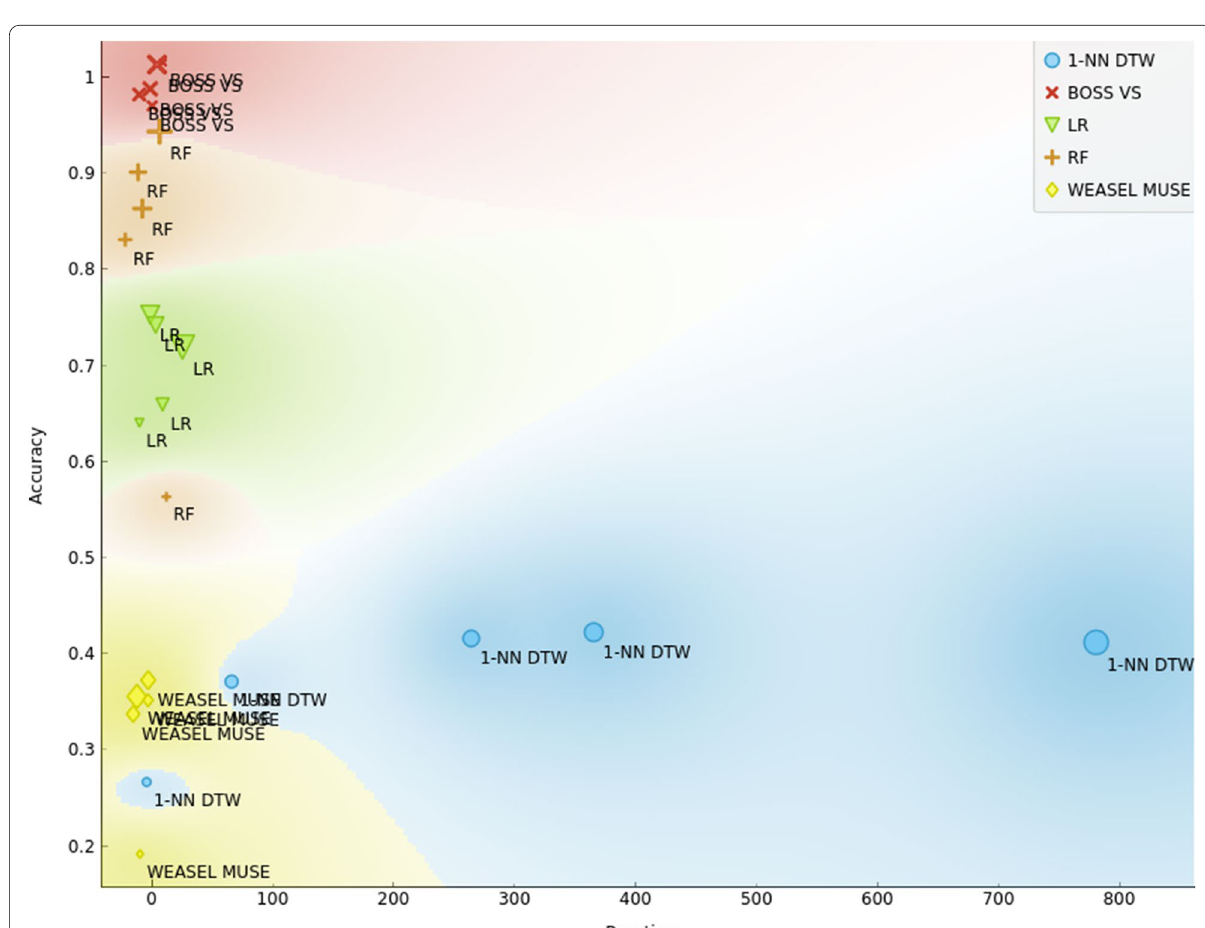
Fig. 10 Accuracy comparison of five models (WEASEL MUSE, BOSS VS, Random Forest, Logistic Regression, and 1‑Nearest‑Neighbor DTW). 1‑NN DTW model shows the worst performance both in accuracy and run time. On the contrary, the BOSS VS model shows excellent accuracy over the others. Note: the upper left being the overall best